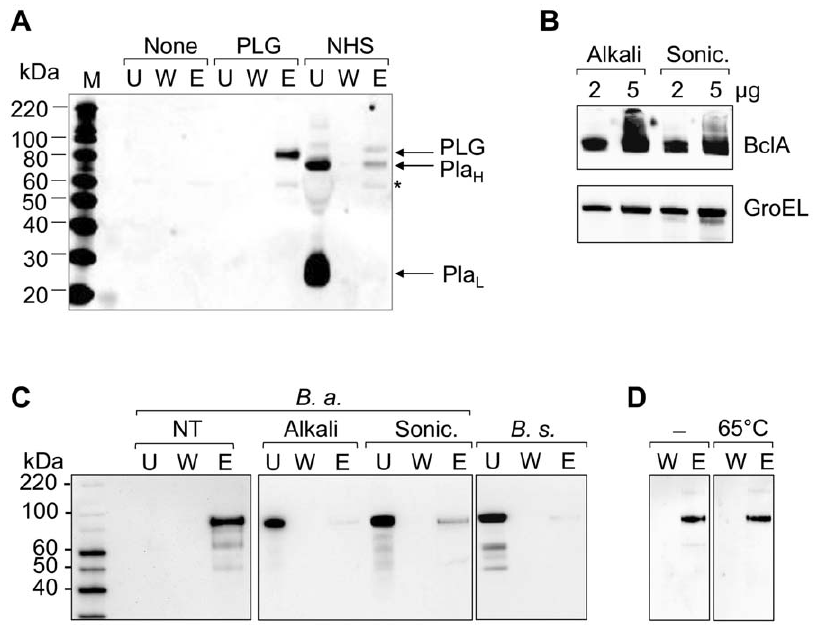
Figure 2. Binding of PLG to B.anthracis spores is exosporium-dependent. (A) Spores (1.6 6 10 9 ) were incubated with PLG (10 m g) or NHS (150 m l) and washed, and bound proteins were eluted by 3 M potassium thiocyanate. (A) Western blot of 5 th washed ( W ) and eluted ( E ) fractions with anti-PLG antibody. Lane W demonstrates an absence of detectable protein in the last wash before elution. U indicates unbound proteins. Pla H and Pla L represent heavy chain and light chain of plasmin, respectively. (B) Exosporium was removed by alkaline DTT-SDS-NaCl buffer or sonication as described in Materials and Methods. Removal of exosporium was confirmed by Western blot analysis of major exosporium proteins BclA and GroEL. (C) Exosporium-positive (NT), exosporium-negative (by alkaline extraction or sonication), or B. subtilis 168 spores were incubated with PLG and eluted by a chaotropic reagent. Bound PLG was analyzed by Western blotting as described. U , unbound; W , 5 th wash; and E , elution with a chaotropic salt. (D) B. anthracis spores were incubated at 65 u C for 30 min, and subjected to PLG binding assay as described above. No significant change of PLG binding by heat treatment (65 u C) was seen compared with no heat treated control